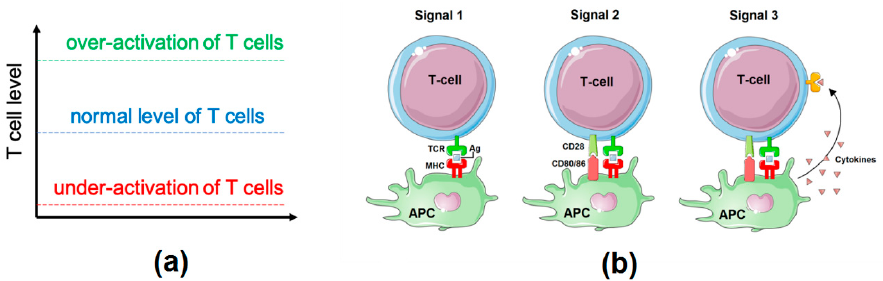
Figure 1. T cell activation. ( a ) Levels of T cell activity considered in the model: normal levels (blue) will be considered as no-activation; high levels (green) will be equivalent to a boost of T cell activation and referred to as T cell proliferation, and under-activation (red) corresponds to immunodeficiency cases. ( b ) Three steps of activation of T cells following adaptive immune response T cell